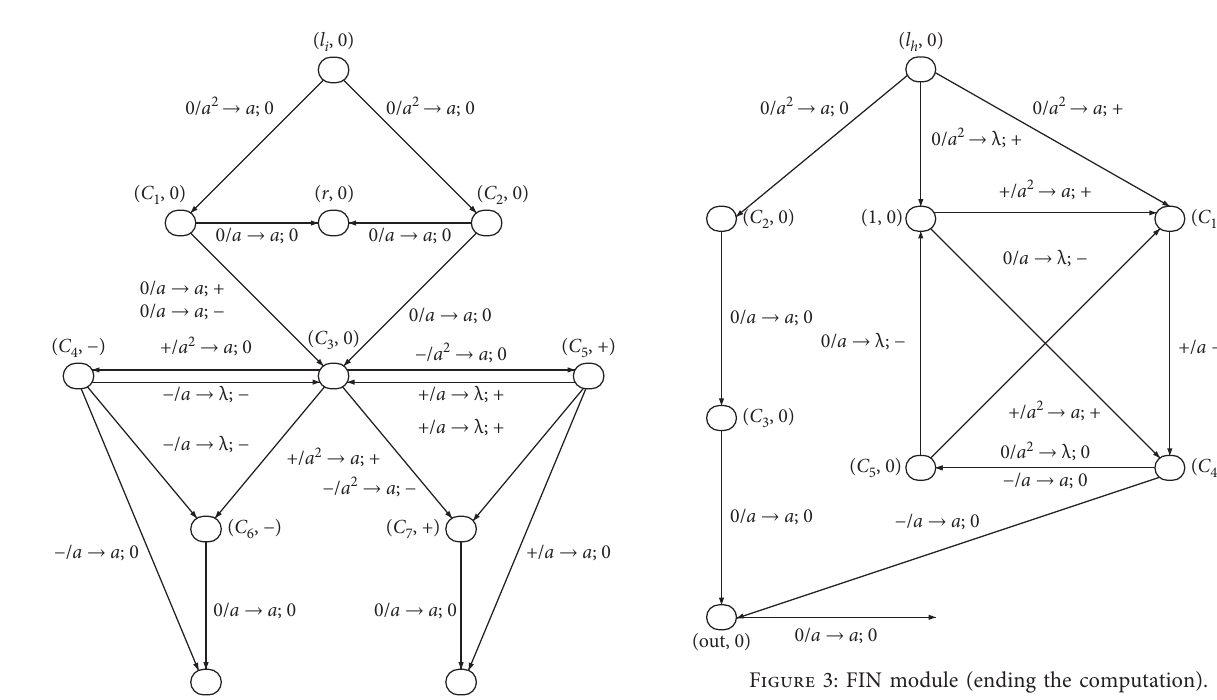
( ADD ( r ) ,l , l ) ). i : j k